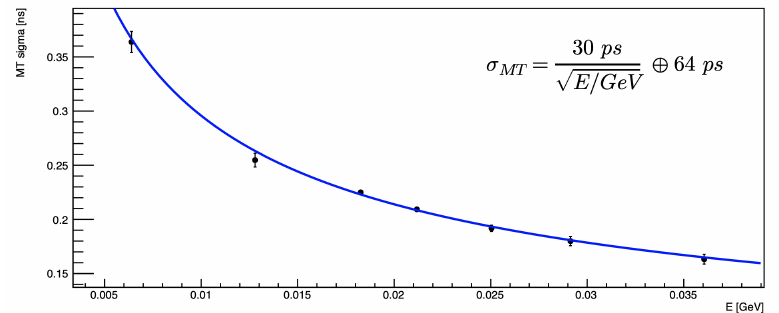
Figure 14. Central crystal mean time resolution for different energy slices (central